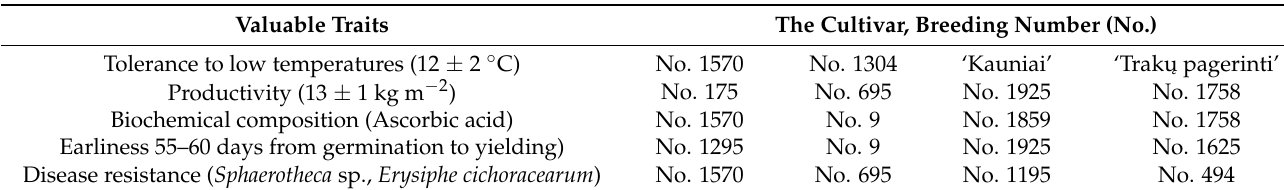
Table 2. Parental material from cucumber national and adapted genetic resources. Valuable Traits